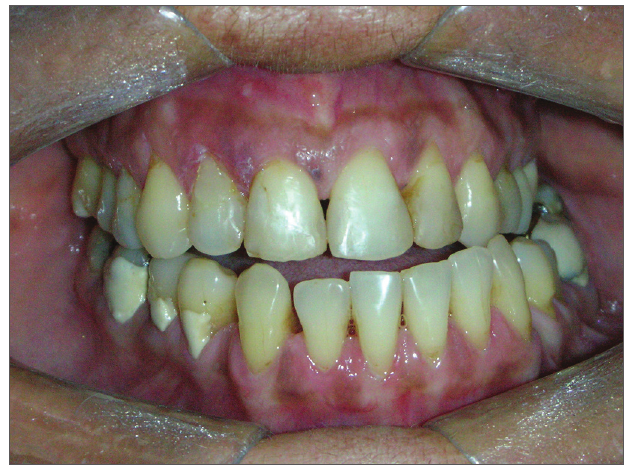
Figura 4. Alterações oclusais: desvio de linha média e mordida cruzada por osteoma em côndilo mandibular direito.